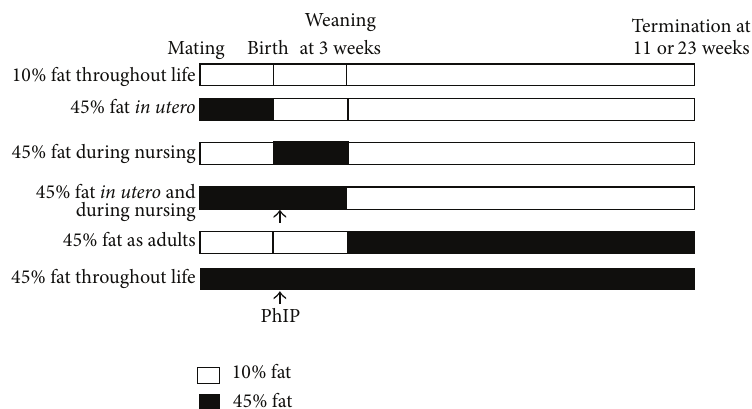
Figure 1: Experimental design. The mice were exposed to a 45% fat diet for combinations of three periods in life; (1) in utero , via the dams, (2) from birth to weaning, via milk during nursing, or (3) from weaning at 3 weeks to termination at 11 weeks of age (for Min/+ mice) or 23 weeks (for wild-type mice), to determine the most susceptible exposure period for development of obesity and intestinal tumorigenesis as adults. The effects of a 45% fat diet were studied on spontaneous tumorigenesis induced by the inherited mutation in the Apc gene and on tumors induced by the the food mutagen and carcinogen 2-amino-1-methyl-6-phenylimidazo[4,5- b ]pyridine (PhIP). The mice in two experimental groups (marked with arrows) were given one s.c. injection of 25 mg/kg body weight of PhIP on days 3–6 after birth. In total, eight experimental groups were included in this experiment; a 10% fat diet throughout life as a negative control (10+10+10), a 45% fat diet in utero (45+10+10), a 45% fat diet during the nursing period (10+45+10), a 45% fat diet both in utero and during nursing (45+45+10), exposed to PhIP or not, a 45% fat diet as adults (10+10+45), or a 45% fat diet throughout life (45+45+45), exposed to PhIP or